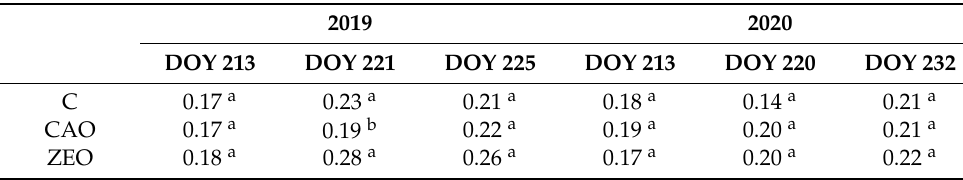
Table 4. Leaf stomatal conductance (g s , mol m − 2 s − 1 ) during the 2019 and 2020 seasons. Measure- ments were taken on three well-exposed leaves per vine. Different letters within a column indicate significant differences as calculated by the Tukey statistical analysis test ( p ≤ 0.05).